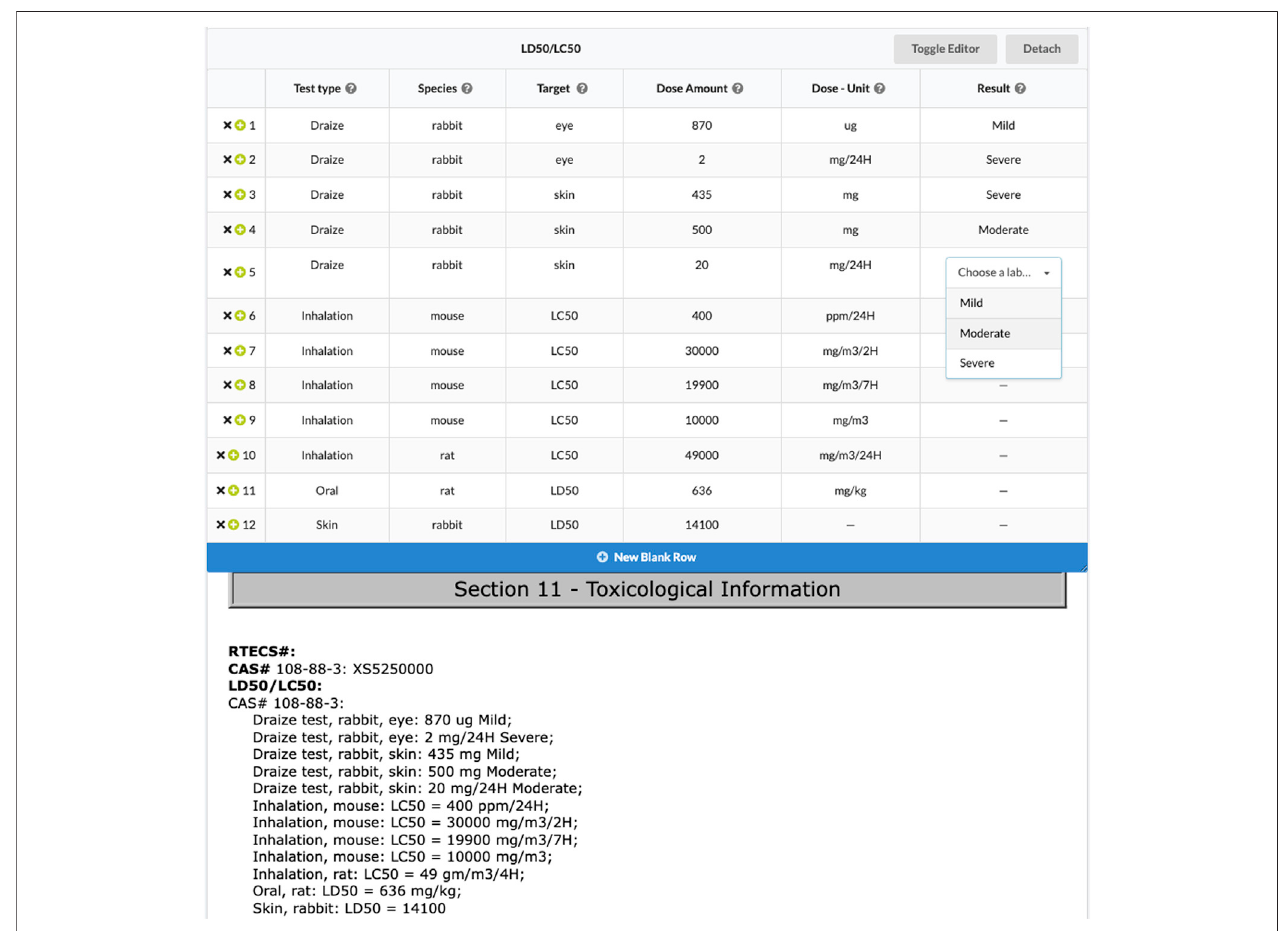
FIGURE2| Users extracttesting informationfromasafetydatasheetusing agrouplabel.Theresultsofthissafetydatasheet reviewareavailable(withpdf hidden) at sysrev.com/o/2/p/31871/article/8296525.